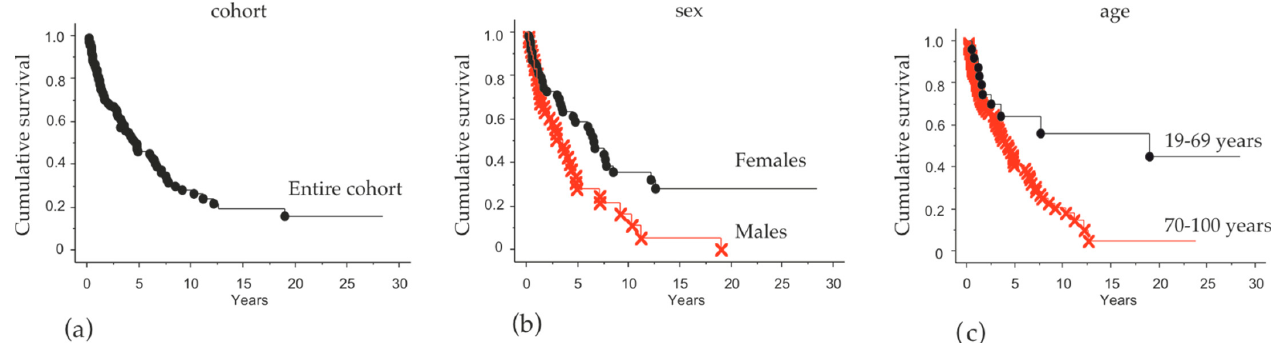
Figure 1. Overall survival analysis in relation to gender and age. Kaplan–Meier plots illustrating overall survival (OS) in: ( a ) the entire cohort; ( b ) Female (black) vs. Male (red) p = 0.04; and ( c ) age groups 19–69 years (black) vs. >70 years (red) p = 0.005.